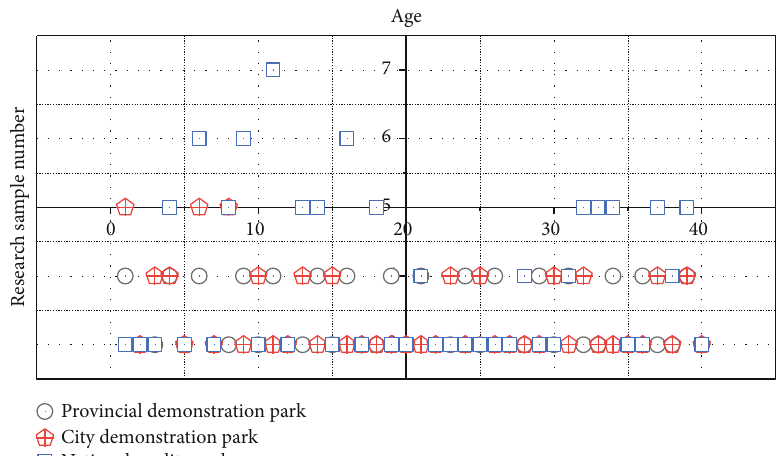
Figure 2: The age distribution of the survey samples.